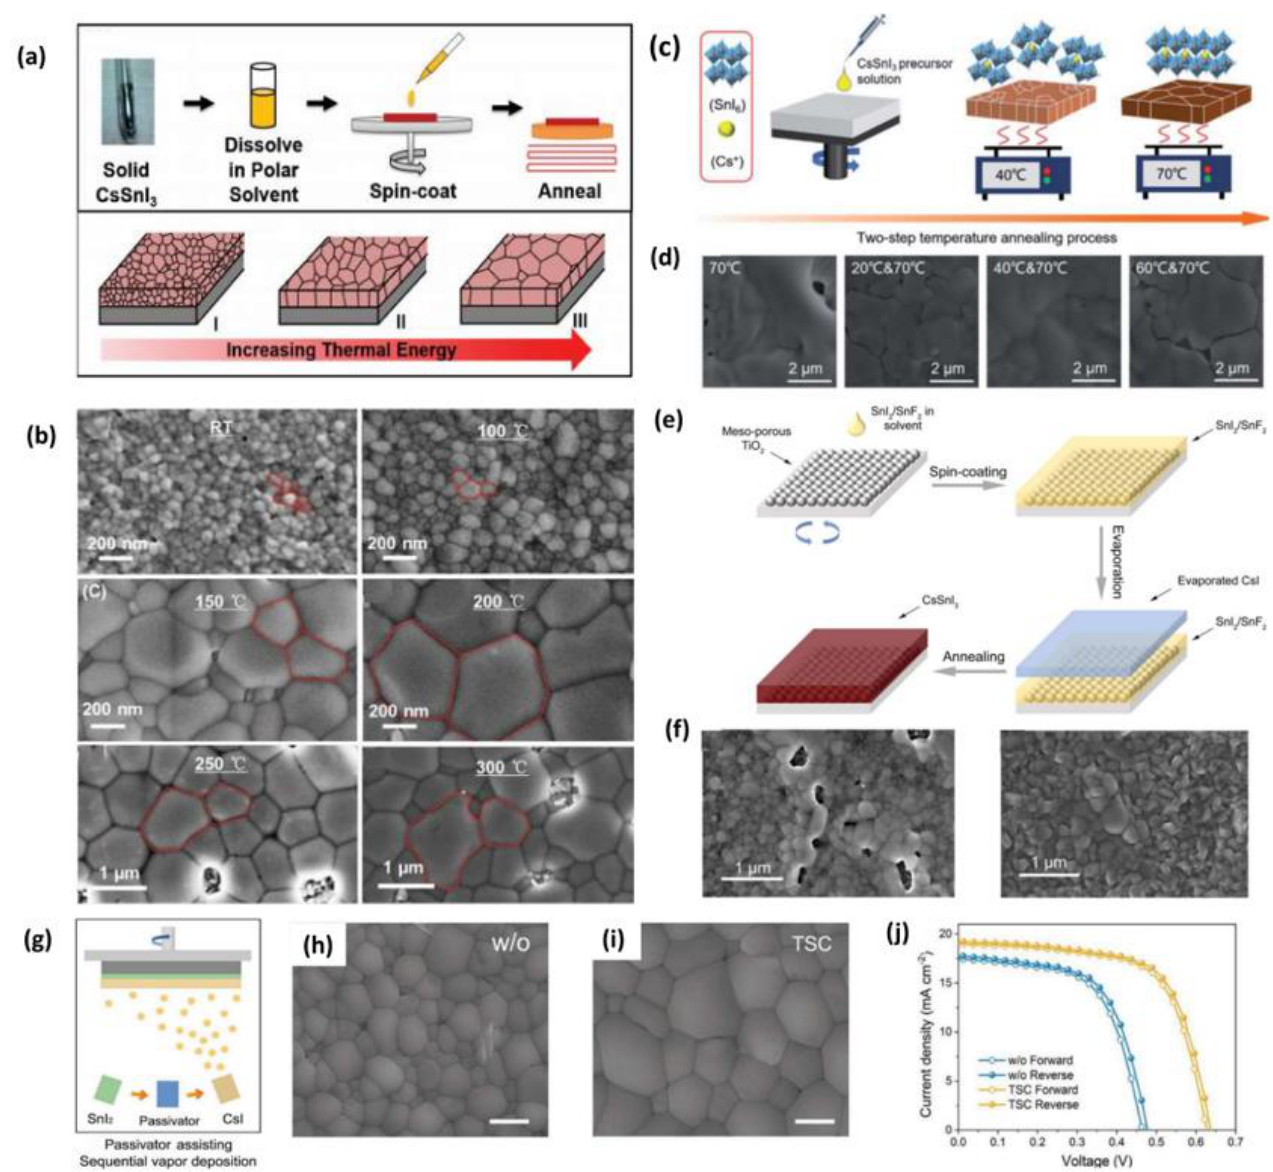
Figure 6. ( a ) Illustration of one-step solution fabrication and the grain-coarsening driven morphol- ogy evolution of as − deposited B −γ− CsSnI 3 thin film with increasing heat − treatment temperature. ( b ) SEM pictures of the CsSnI 3 films annealed at different temperatures [94]. ( c ) Illustration of the two-step temperature annealing process of B −γ− CsSnI 3 thin films. ( d ) Surface SEM images of CsSnI 3 films employing different annealing procedures [95]. ( e ) Schematic representation of the evaporation– assisted solution technique. ( f ) Top − view SEM pictures of annealed CsSnI 3 films with different CsI thicknesses [88]. ( g ) Schematic representation of the PASVD technique for fabricating CsSnI 3 perovskite films. ( h , i ) SEM pictures of CsSnI 3 films without and with TSC addition. ( j ) The best performance for with and without TSC passivated of CsSnI 3 PVSCs [28].